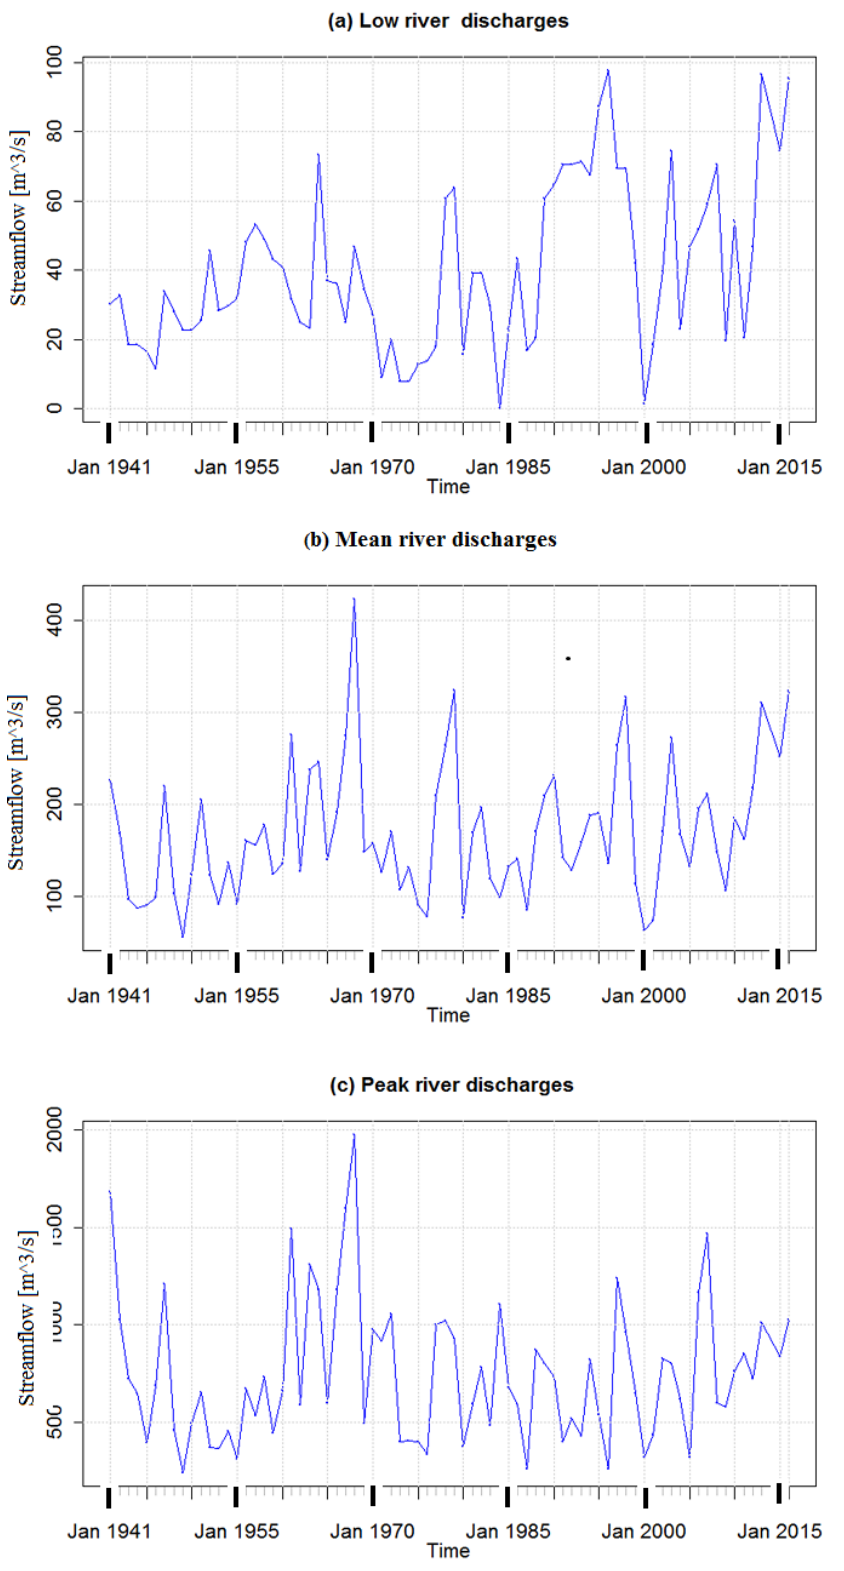
Figure 4 . Extremal values of Tana River from Garissa stage gauge records (2000–2016) . Figure 4. Extremal values of Tana River from Garissa stage gauge records